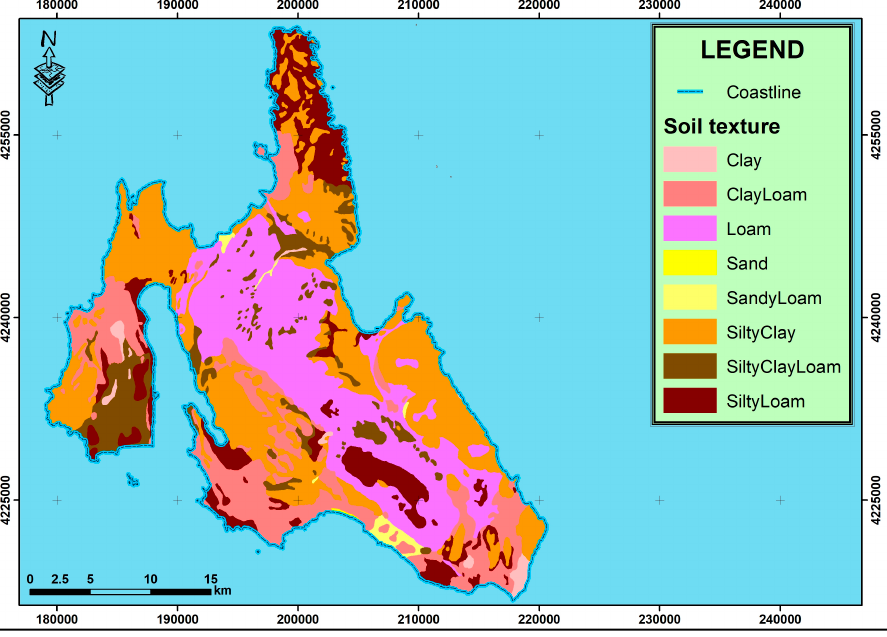
Figure 1. Soil erodibility factor ( Κ ) map of Cephalonia